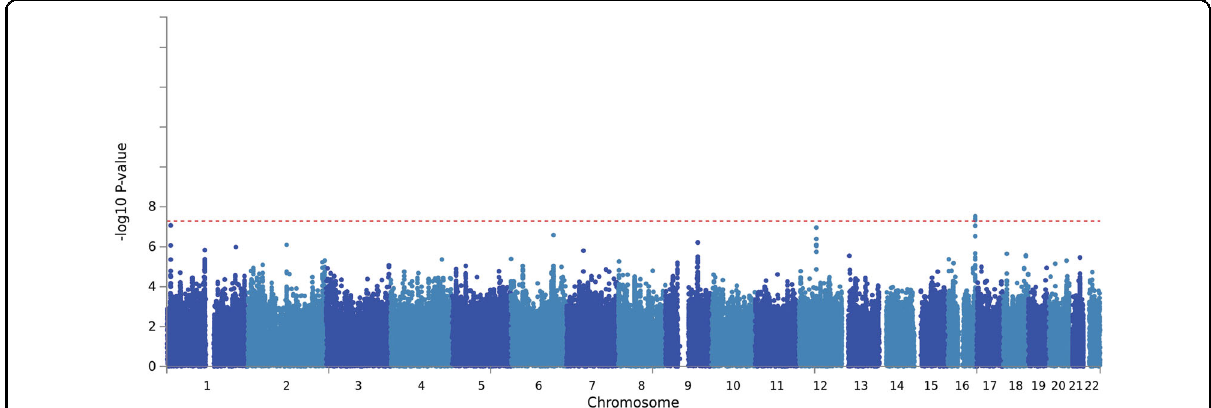
Fig. 1 Manhattan plot for GWAS fi xed effect meta-analysis of TD. Note: Three cohorts were included in the fi xed-effect meta-analysis, STCRP, CATIE-EUR, and CATIE-AFR. A single GWAS signal was found at 16q24.1 for rs11639774.